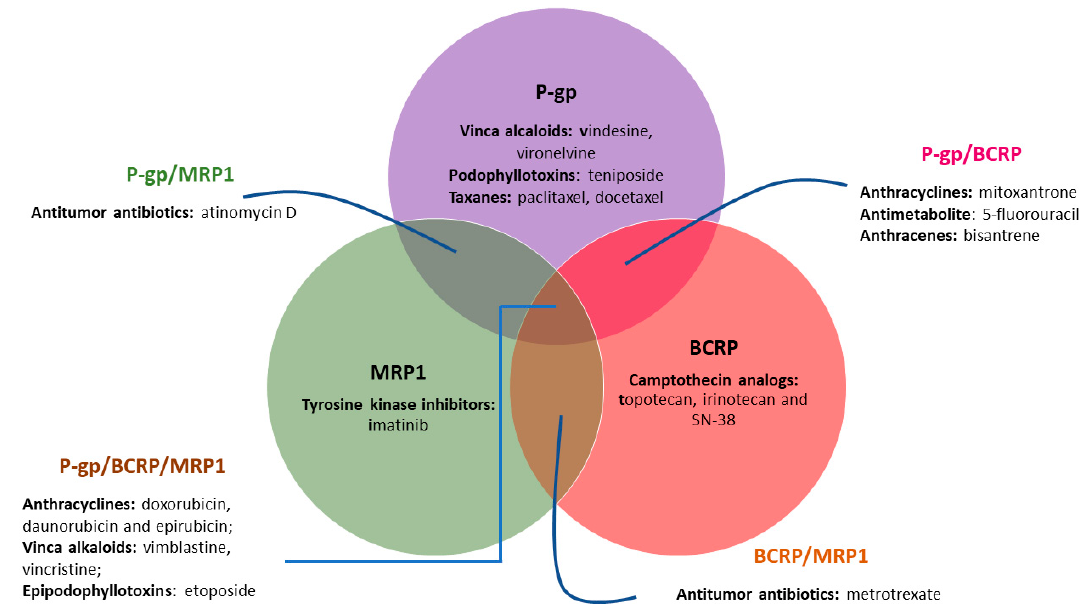
Figure 2. Anticancer drug substrates of P-gp, MRP1 and BCRP. As depicted in the figure, P-gp, MRP1, and BCRP have an overlapped specificity for a variety of substrates.